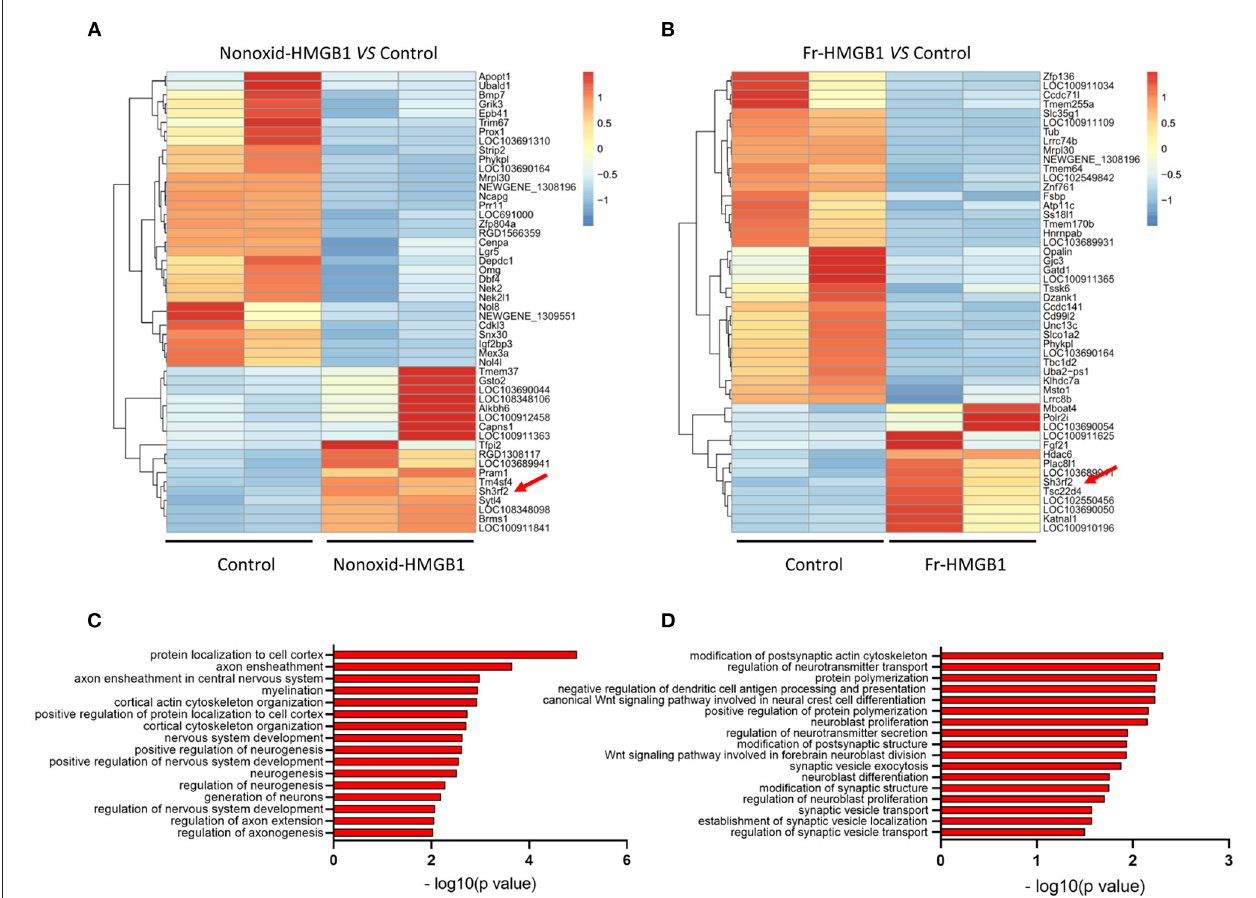
FIGURE 2 | The transcriptome sequence and bioinformatics analysis. (A) The heat map of top 50 DEGs in the nonoxid-HMGB1 group vs. the control group. (B) The heat map of top 50 DEGs in the fr-HMGB1 group vs. the control group. (C) GO analysis for DEGs in the nonoxid-HMGB1 group compared with the control group. (D) GO analysis for DEGs in the fr-HMGB1 group compared with the control